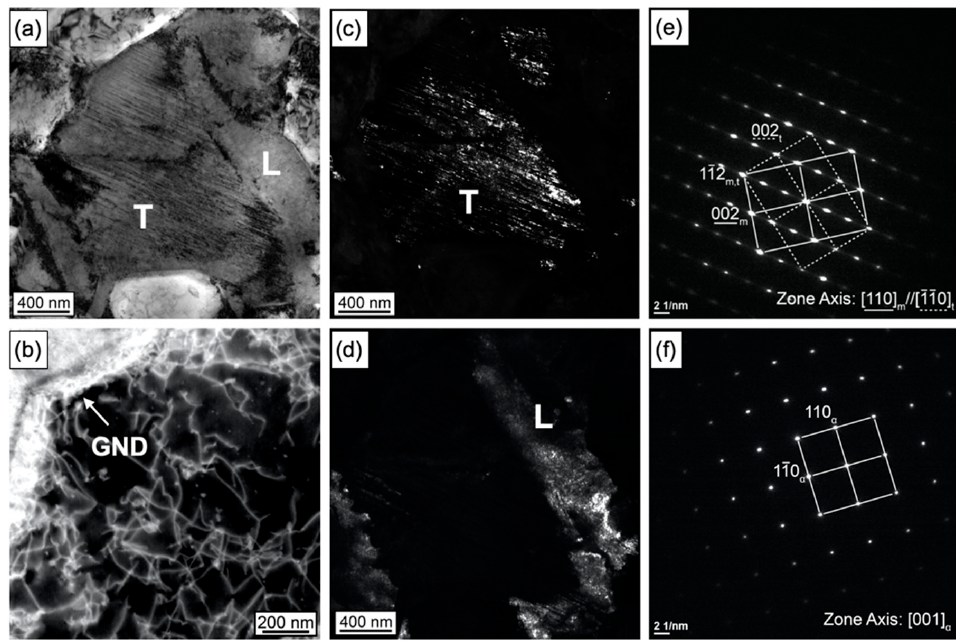
Figure 7. Identification of microstructural details after final conditioning by TEM: ( a ) co-existence of lath (L) and twinned (T) martensite; ( b ) geometrically necessary dislocations (GND) at boundary between ferrite and martensite; ( c , e ) twinned martensite; ( d , f ) lath martensite.